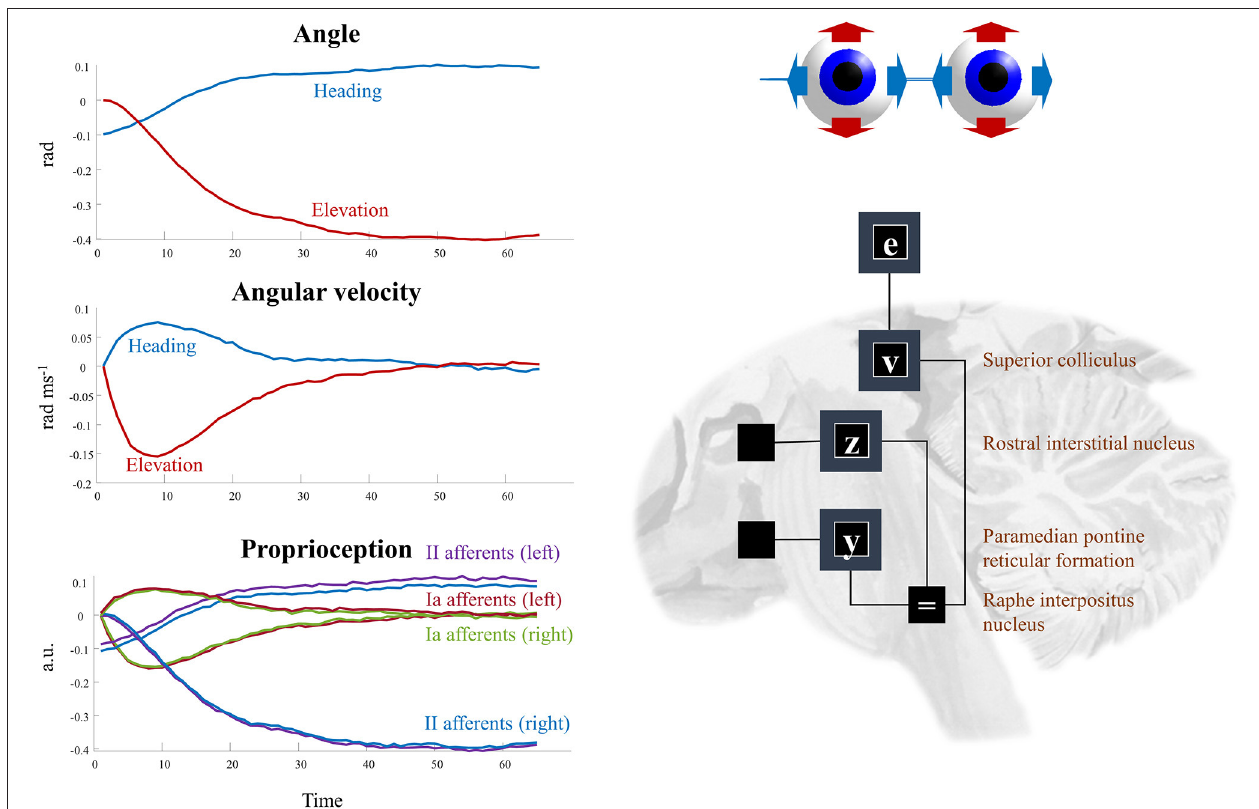
FIGURE 6 | Oculomotion. The plots on the left of this figure show an example of the kinds of dynamics that result from Equations (9–12). These illustrate a single saccade toward some equilibrium point determined by factor v . The first two plots detail the hidden states, comprising the heading angle of the eyes, their elevation, and the rates of change of each of these. In addition, the third plot illustrates the proprioceptive data we might expect these dynamics to generate. These are divided into sensory neurons that report instantaneous muscle tendon stretch (II afferents) and those that report changes in this (Ia afferents) for the right and left eye. Note that these differ only in the heading angle—as eye movements are congruent. The constant discrepancy in the heading angle results from the angle of convergence of the eyes. On the right, the factors are arranged to be consistent with the brainstem structures that deal with saccades in the vertical (factor z ) and horizontal (factor y ) directions. The proprioceptive signal is expressed in arbitrary units (a.u.) which could be converted to firing rates with the appropriate (e.g., sigmoidal)